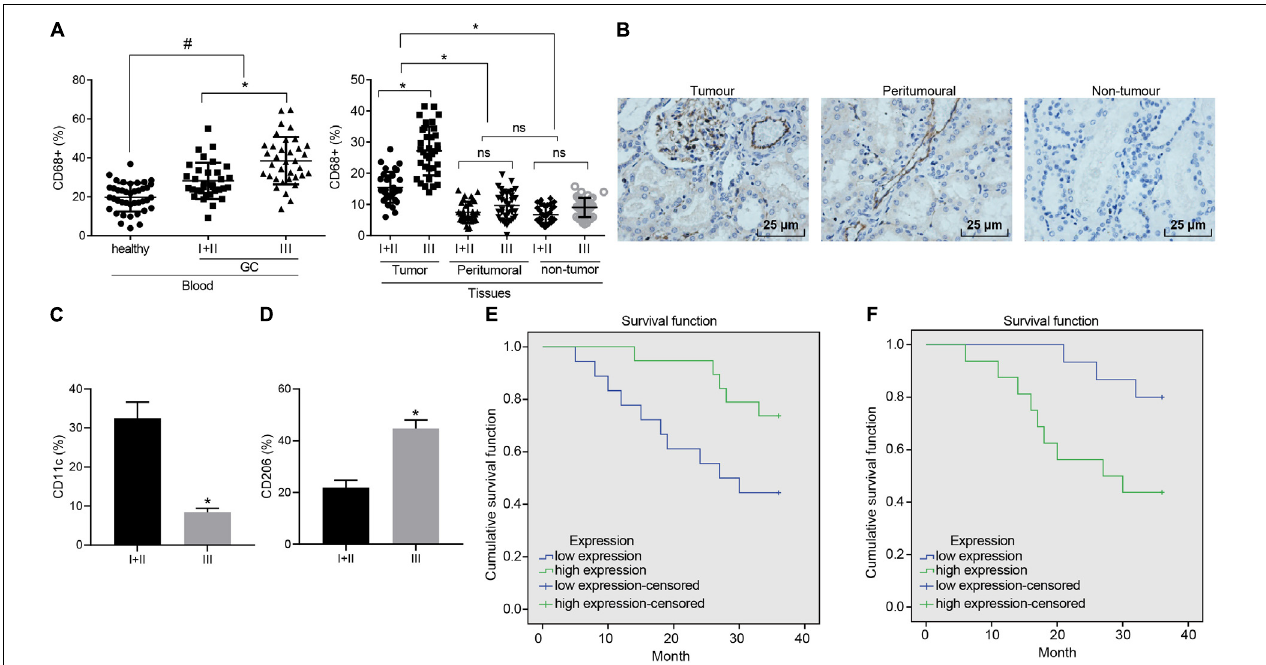
FIGURE 1 | Enrichment of M1 macrophages is associated with GC progression. (A) Expression of CD68 + macrophages in peripheral blood of GC patients and healthy donors, cancerous, tumor-adjacent, and non-cancerous stomach tissues detected by flow cytometry (healthy donors: n = 40; GC patients: n = 68). (B) Immunohistochemical staining of CD68 + macrophages in cancerous, tumor-adjacent, and non-cancerous stomach tissues (400 × ). (C) The ratio of CD68 + M1 macrophages (CD11c) in patients at different stages assessed by flow cytometry. (D) The ratio of CD68 + M2 macrophages (CD206) in patients at different stages assessed by flow cytometry. (E) Kaplan–Meier survival analysis of the correlation between M1 macrophages (CD11c) and OS of GC patients. (F) Kaplan–Meier survival analysis of the correlation between M2 macrophages (CD206) and OS of GC patients. Measurement data representative of three independently performed experiments expressed as mean ± standard deviation. Comparisons between two groups are analyzed by non-paired t test, with comparisons among multiple groups are analyzed by one-way ANOVA followed by Tukey’s test. Kaplan–Meier method is applied to test the OS of GC patients. * p < 0.05 compared with stage I and stage II gastric cancer patients; # p < 0.05 compared with healthy